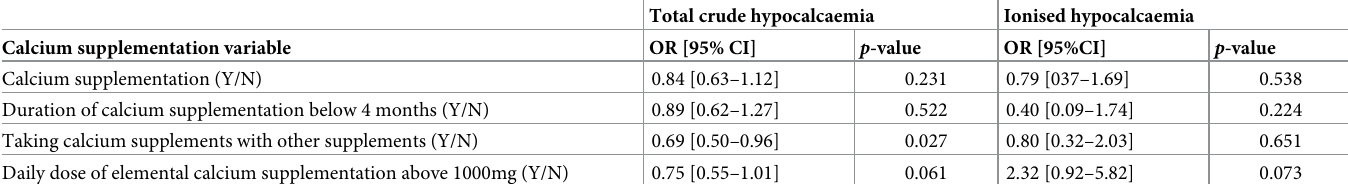
Table 7. Logistic regression analysis between calcium supplementation variables and likelihood of total crude and ionised